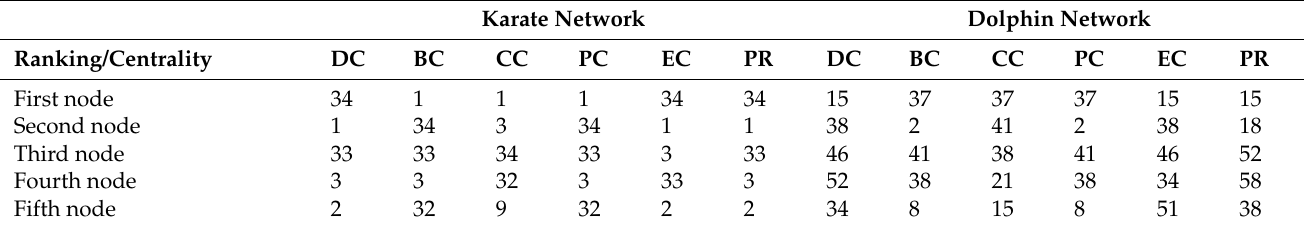
Table 3. Rank of the nodes from Karate and Dolphin networks according to the centrality scores. Karate Network Dolphin Network